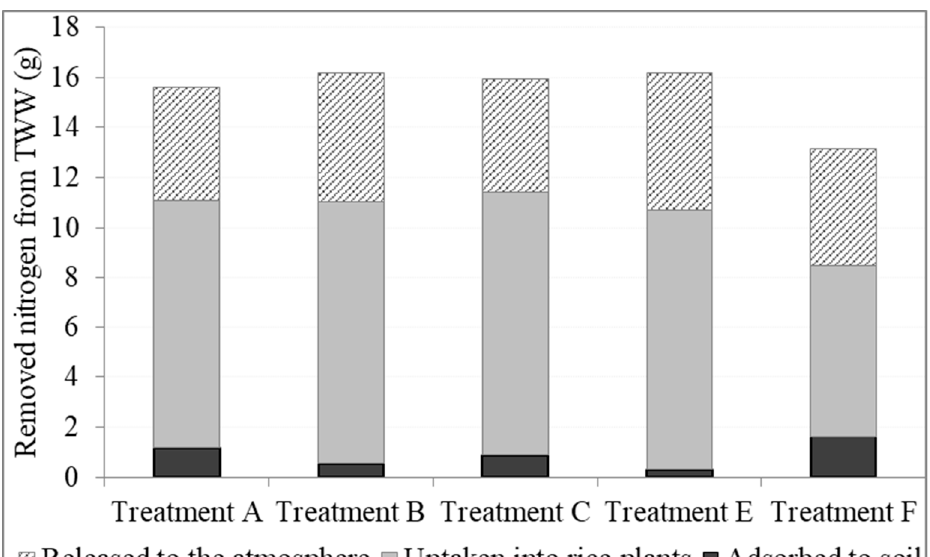
Figure 3. Fate of nitrogen removed from irrigation water.